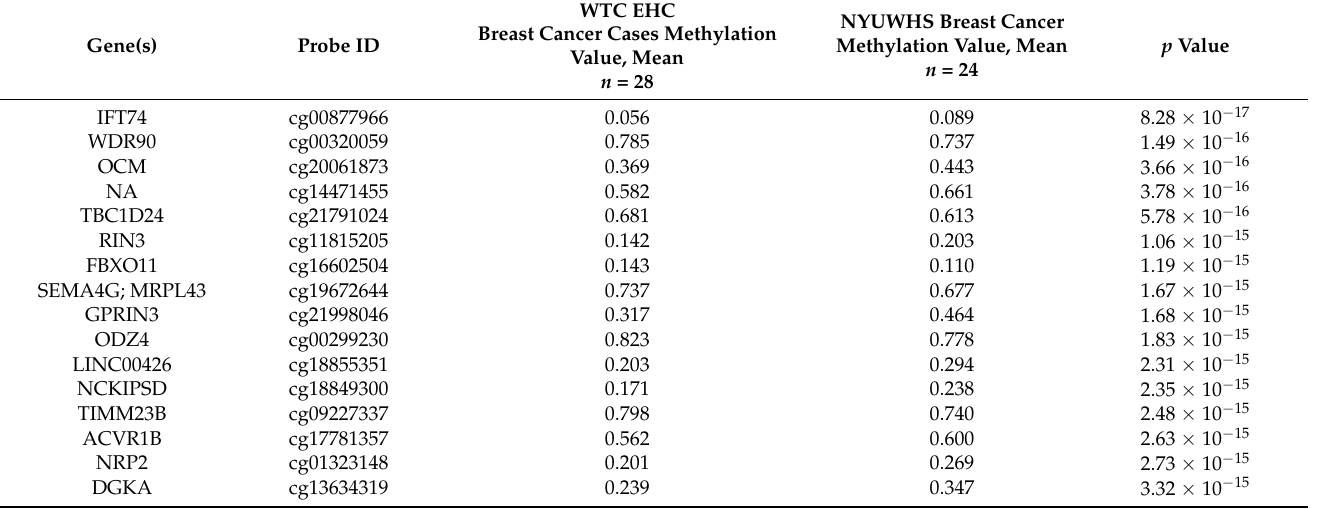
Table 2. Top differentially methylated probes, and top 15 gene-associated probes, comparing WTC- exposed (WTC EHC) breast cancer vs. unexposed (NYUWHS) pre-diagnostic breast cancer cases.